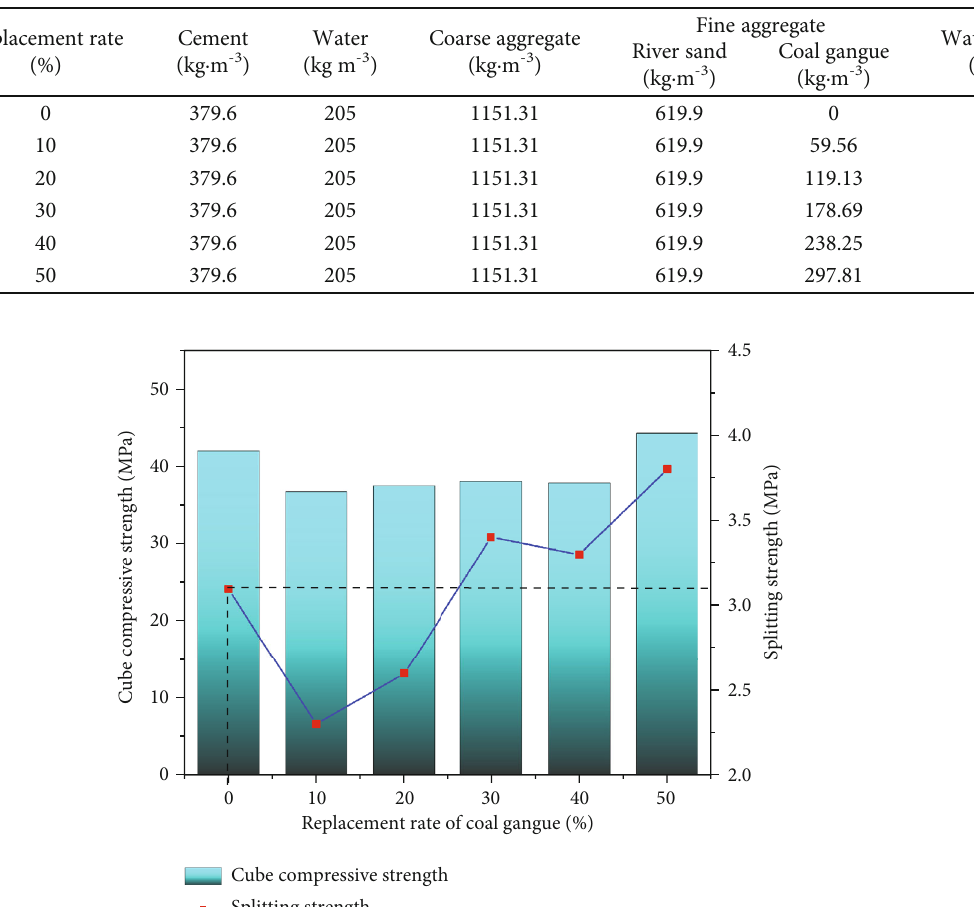
Figure 5: Test of fl exural strength. Table 1: Concrete mix proportion.